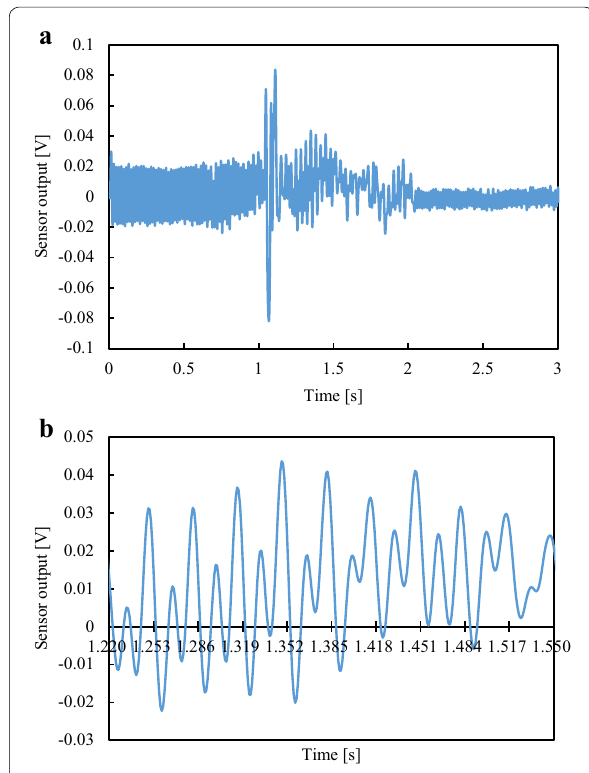
Fig. 13 Filtered sensor output in blood vessel model No. 2 (convexity